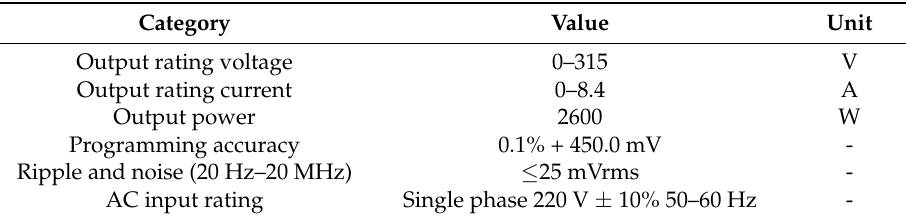
Table 3. Specifications of the programmable DC power supply.